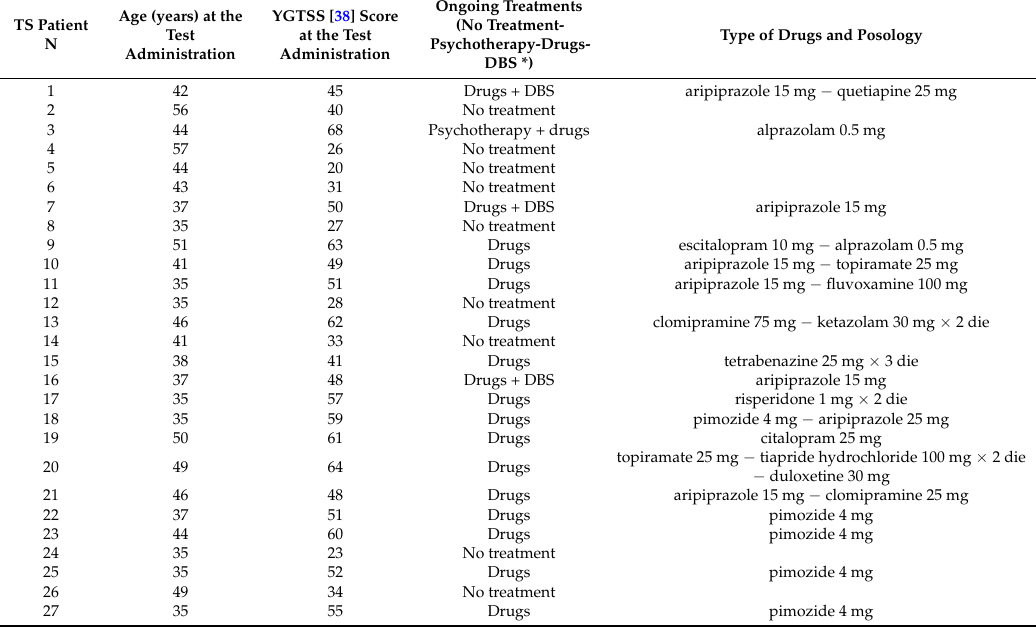
Table 1. Age, The Yale Global Tic Severity Scale (YGTSS) [38] score and ongoing treatments of Tourette Syndrome (TS) sample.